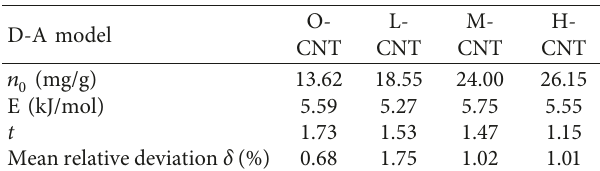
Table 3: Adsorption parameters of the D-A model for methane adsorption isotherms.